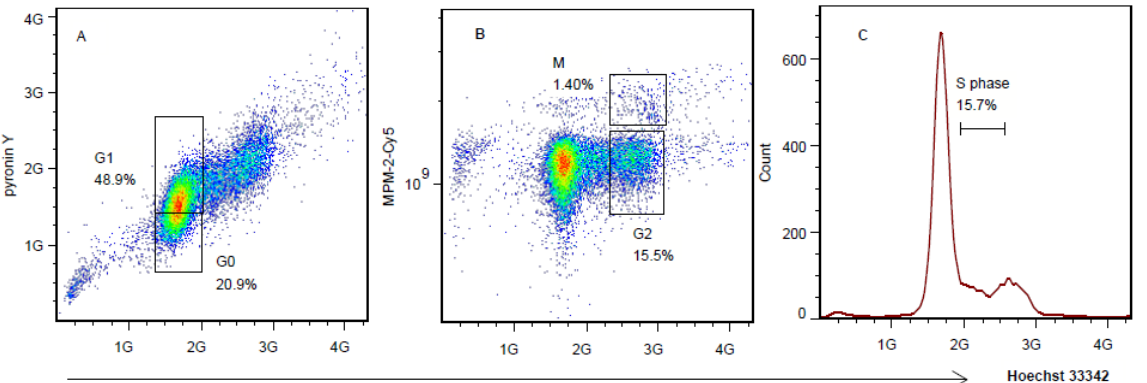
Figure 3. Distribution of cell cycles in SMMC-7721 cells and the bivariate distribution of DNA content (Hoechst 33342), RNA content (pyronin Y), and mitotic phosphoproteins (MPM-2-Cy5 fluoresence) in SMMC-7721 cells. ( A ) The bivariate dot plots showing DNA content (x axis = Hoechst 33342 fluorescence) and RNA content(y axis = pyronin Y fluorescence). The gates were drawn according to the negative control. ( B ) The bivariate dot plots showing DNA content (x axis = Hoechst 33342 fluorescence) and mitotic phosphoproteins content (y axis = MPM-2-Cy5 fluorescence). ( C ) DNA content histogram of SMMC-7721 cell line, stained by Hoechst 33342. Data were obtained in three independent experiments and the representative results were shown. The analysis was carried out without using width/height to delete the